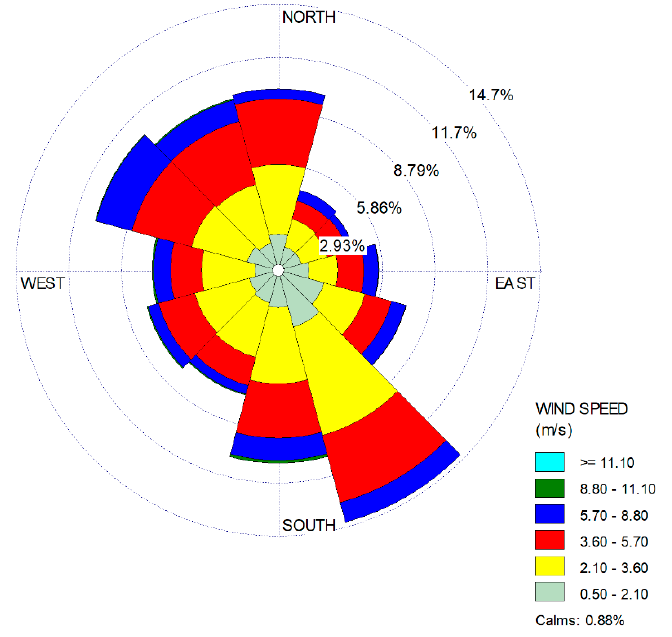
Figure 4. Wind Rose Plot Showing the Wind Patterns at the Project Center for CY 2011.